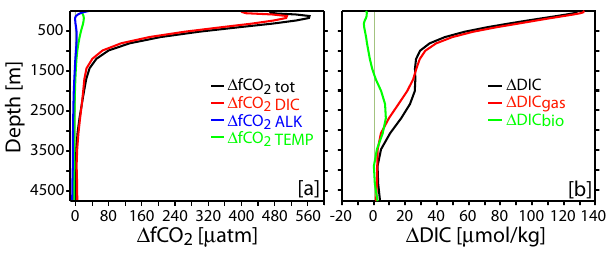
Fig. 11. Panel (a) : depth profile of the f CO 2 changes (difference 2100–1870) in the global ocean for CSM1.4. Attribution of global f CO 2 changes to different drivers: total f CO 2 change (black line), f CO 2 changes due to DIC (red), alkalinity (blue), and temperature (green). Panel (b) : depth profile of the Atlantic DIC changes (difference 2100–1870) for CSM1.4. Attribution of Atlantic Ocean DIC changes to different drivers: total DIC changes ( ∆ DIC, black line), DIC changes due to gas exchange ( ∆ DIC gas , red) and biological cycle ( ∆ DIC bio , green). Fig. 13. Regionally-averaged (105–115 ◦ W, 0–10 ◦ N) depth profile of the Respiration Index, RI, as simulated by CCSM3 for 1870 (red) and 2100 (green) and as computed from the WOA 09 and GLODAP gridded data (black). The blue line is calculated by using the preindustrial f CO 2 values from CCSM3 in combination with projected f O 2 ; the difference between the blue and red line is the 1870–2100 RI change that is attributable to changes in f O 2 .